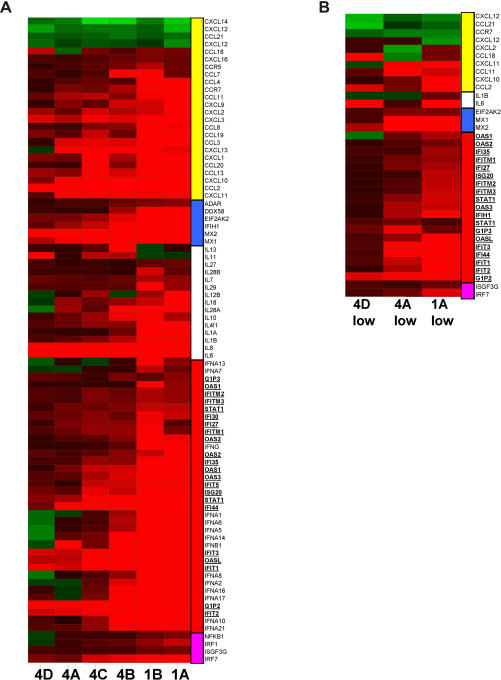
Innate Host Response Profile from Tissues Showing Presence or Absence of Viral mRNAUsing a bioset that contained a selection of genes involved in pathological and antiviral pathways, a heat map was created showing all genes with expression changes > 2 and p < 0.0001 in at least one of the samples with high SARS-CoV levels (A) or in at least one of the samples with low SARS-CoV levels (B). Although there is some functional overlap with genes, the heat map is segregated by functional annotations. Chemokines (yellow), classical antiviral genes (blue), interleukins (white), JAK/STAT pathway, interferons, or ISGs (red), and transcriptional factors (pink). Genes with an absolute fold change > 5 in two day 1 animals and in at least two of the four day 4 animals are indicated with bold, underlined text.